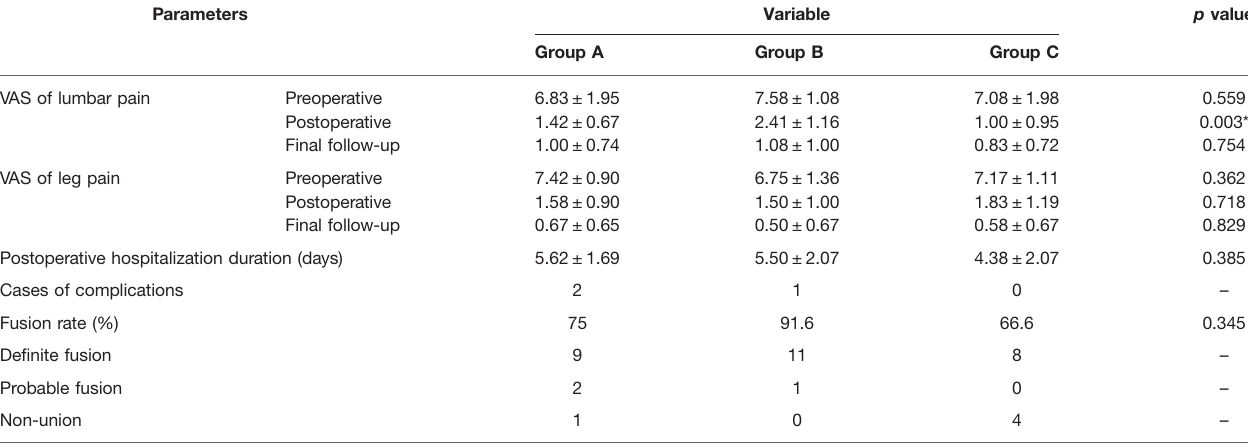
TABLE 3 | Clinical outcomes of three groups that underwent